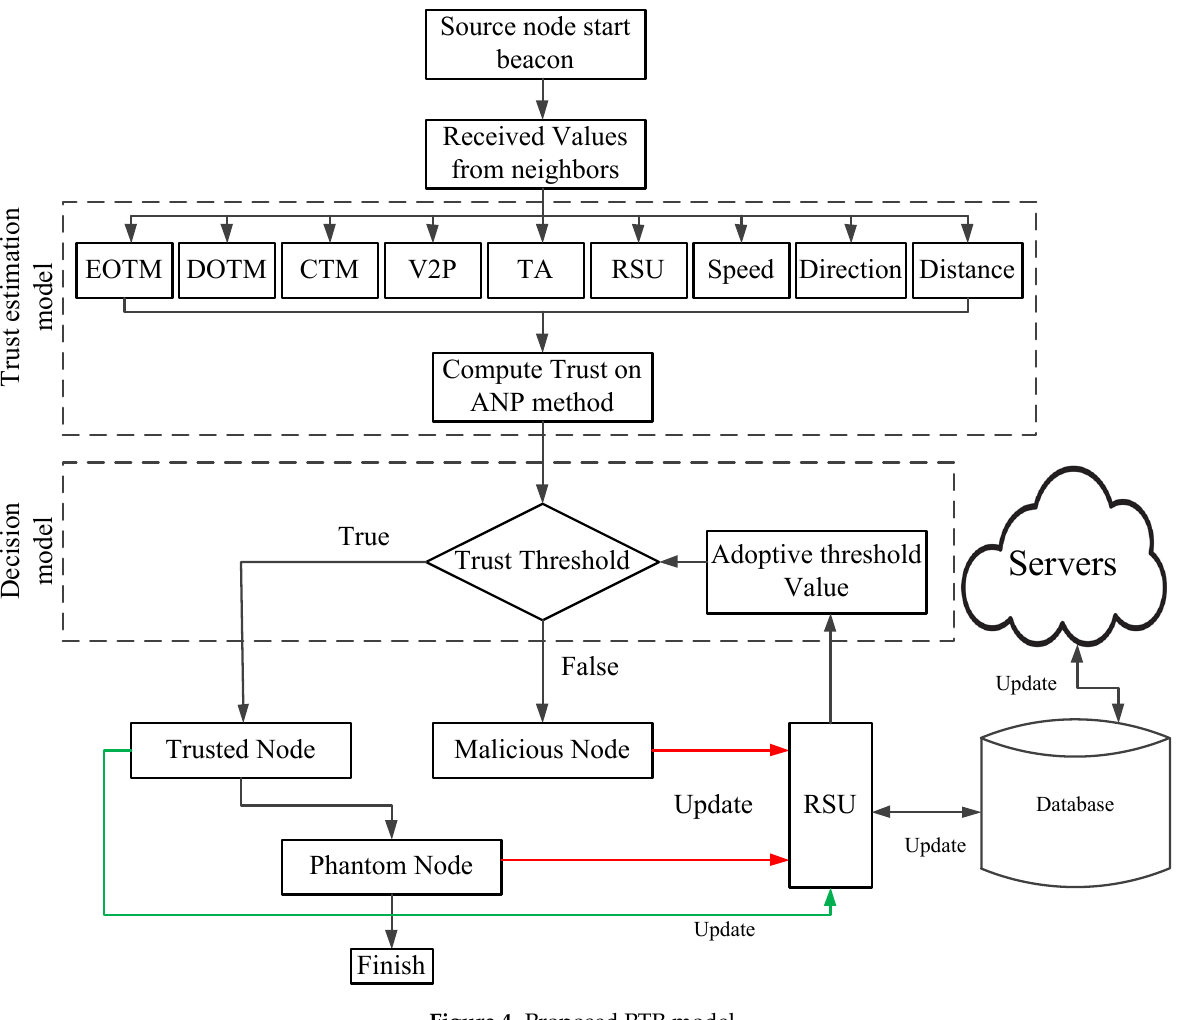
Figure 4. Proposed PTR model.